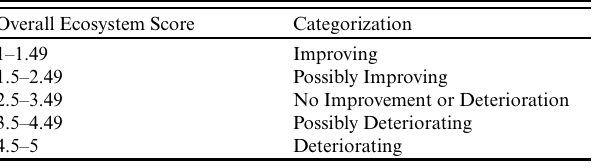
Table 3 . Overall ecosystem scores (after application of weightings) and corresponding ecosystem categories of ecosystem classification (from Lockerbie et al.